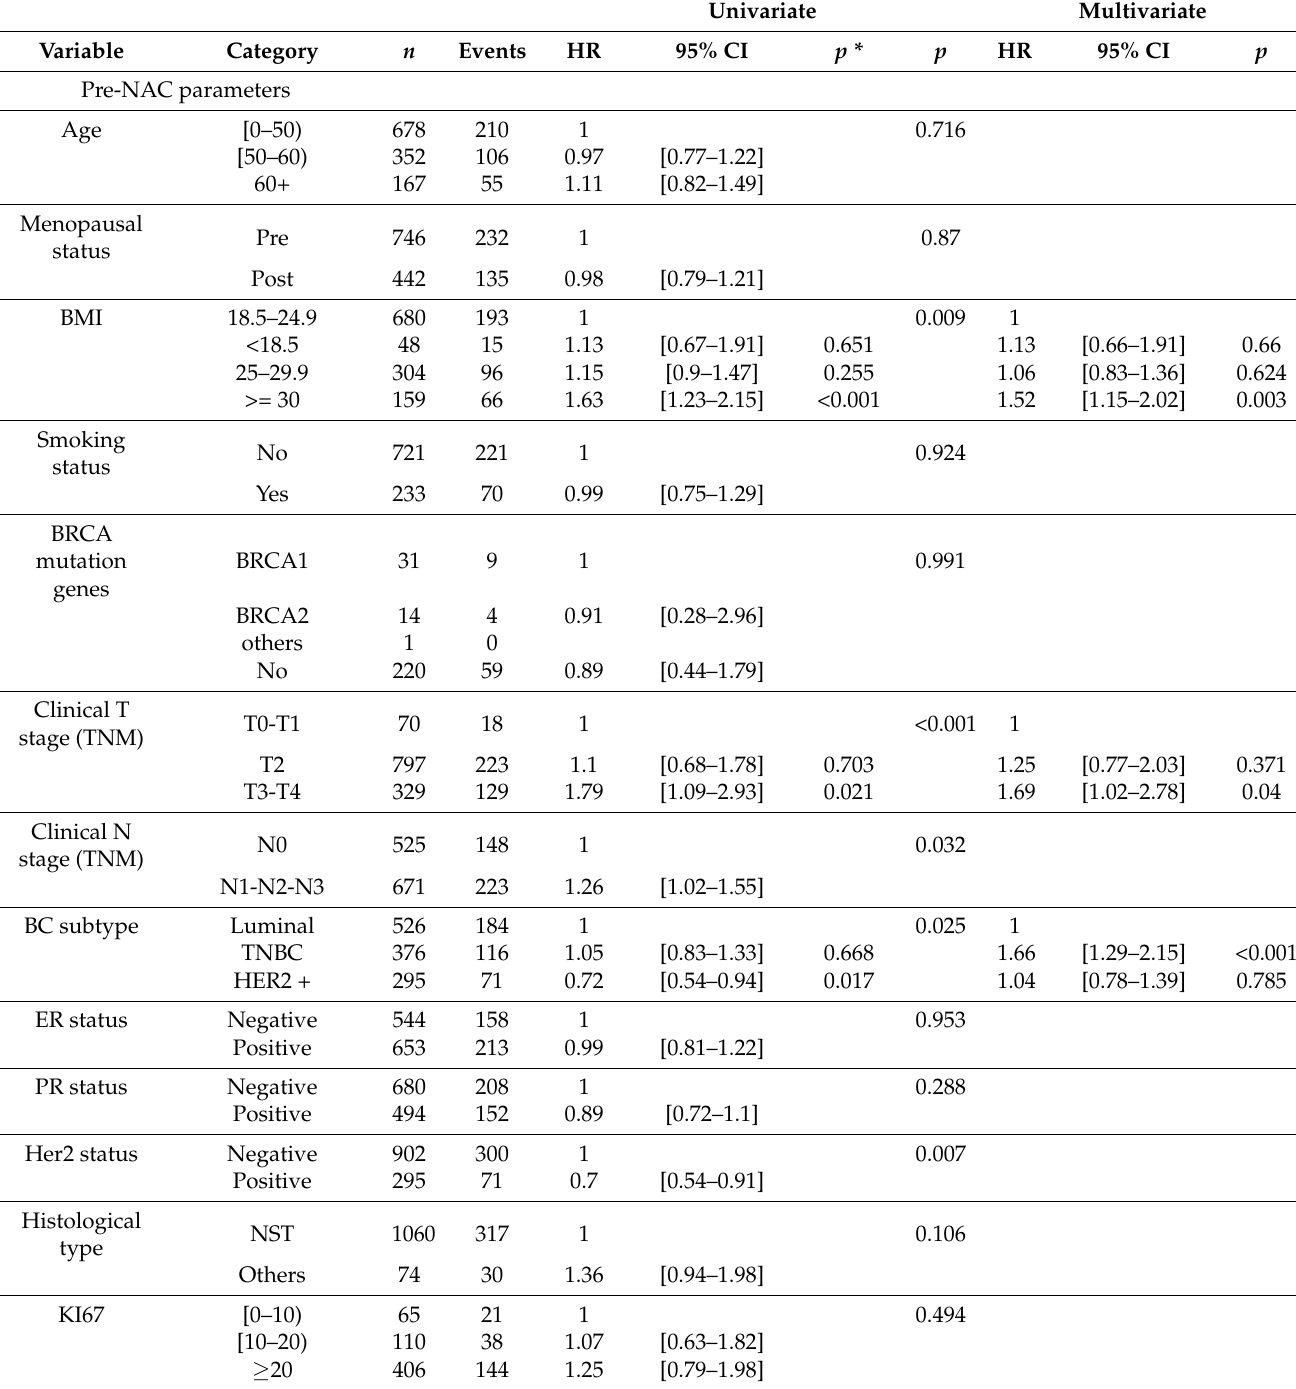
Table 3. Association of clinical and pathological pre and post-NAC parameters with relapse-free survival after univariate and multivariate analysis in the whole